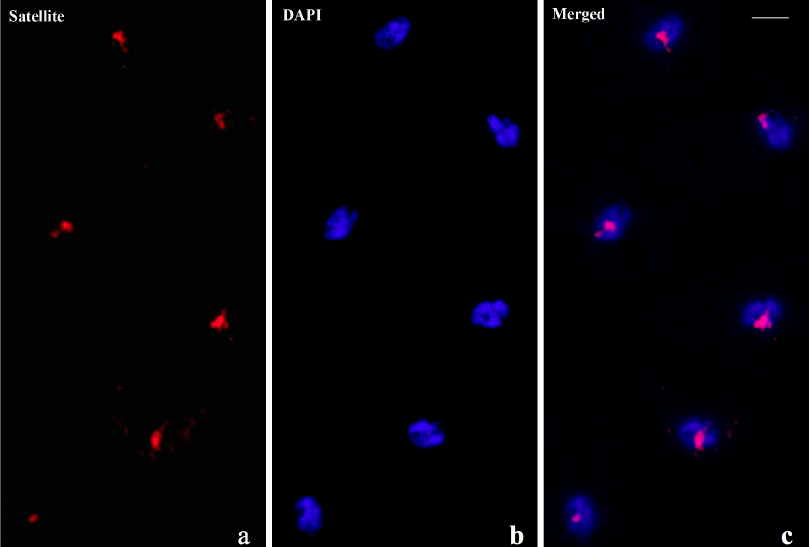
Figure 7. AAGAG repeat probe hybridization to salivary gland nuclei of D. melanogaster carrying the bw D allele prepared in neutral pH omitting chromosomal DNA denaturation. Hybridization detection ( a , Satellite), chromosomal DNA staining ( b , DAPI) and the corresponding merged signals ( c ,